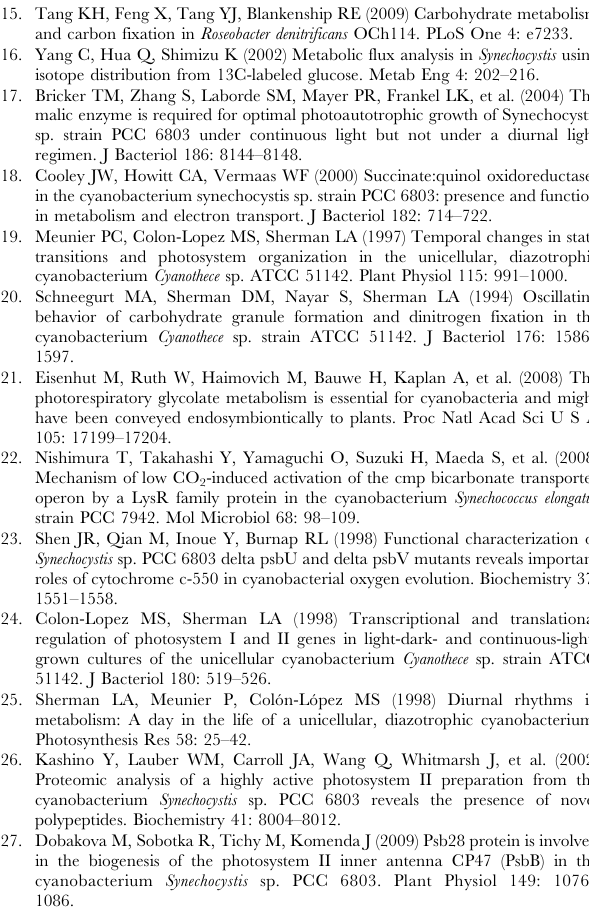
Table S5 Means, standard deviations, intensity values and fold-changes for all proteins detected as cyclic expressed over two consecutive diurnal periods. Spectral count data derived from two technical replicates for both membrane and soluble fractions and resulted in four count values per peptide for each time point. The protein abundance was determined by summing all observed peptides for each protein. These averaged abundance values were used for the cycle detection. The intensity values and fold-changes are given for both days separately. For a number of proteins the fold-changes are undefined (n.d.) because their minimum spectral count values are equivalent to zero. The time points are labeled as D1, D3, D5, D7, D9, and D11 for 1, 3, 5, 7, 9, and 11 hours in the dark, and L1, L3, L5, L7, L9, and L11 for 1, 3, 5, 7, 9, and 11 hours in the light. Table S6 Peak time maxima for mRNA and protein expression profiles with diurnal oscillation pattern. Each expression profile was approximated using the first oscillatory term of the Fourier series expansion. The fold-changes between maximum and minimum intensities for mRNA’s and proteins are given for each day separately. For a number of proteins the